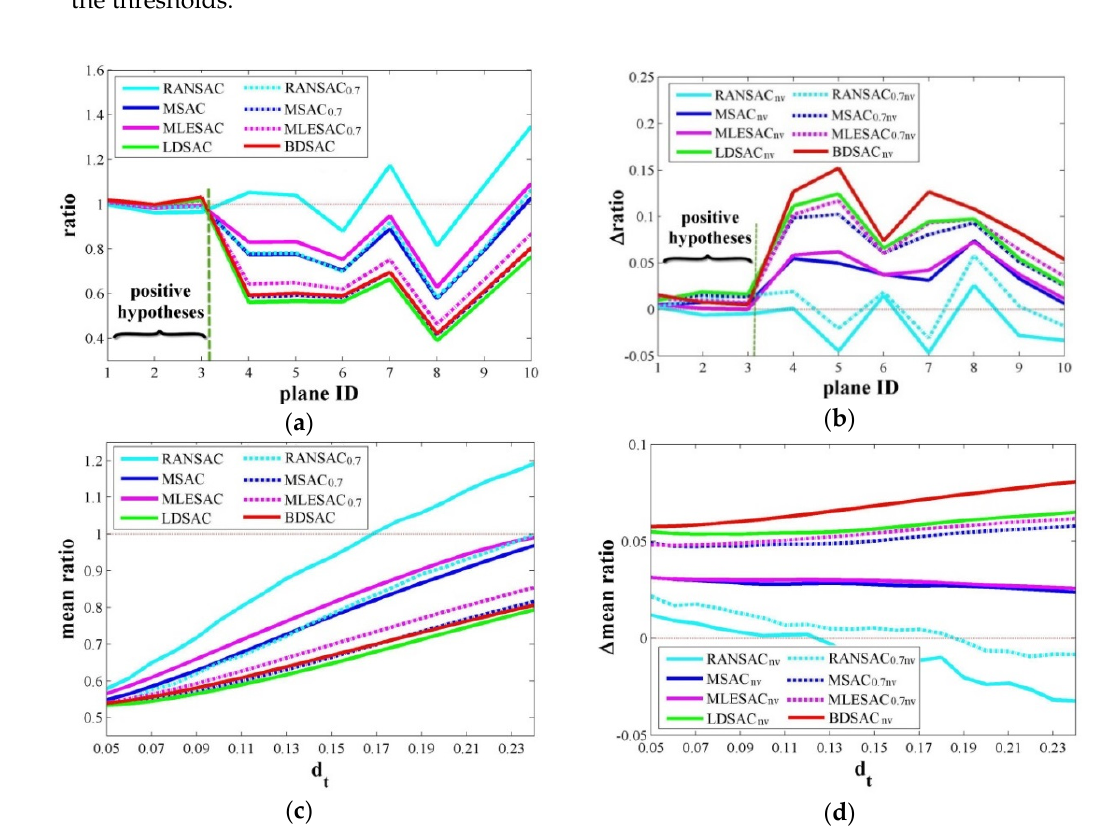
Figure 5. Suppressing ability and threshold sensitivity test. ( a ) Suppressing ratios for planes under different weight forms; ( b ) Ratio reductions after considering the angular difference ( i.e. , the ratio reduction of BDSACnv is the ratio of BDSAC minus the ratio of BDSACnv); ( c ) Mean ratio of the ten planes under different dt thresholds; ( d ) Mean ratios reduction after considering the angular difference (the reduction approach is similar to ( b )).